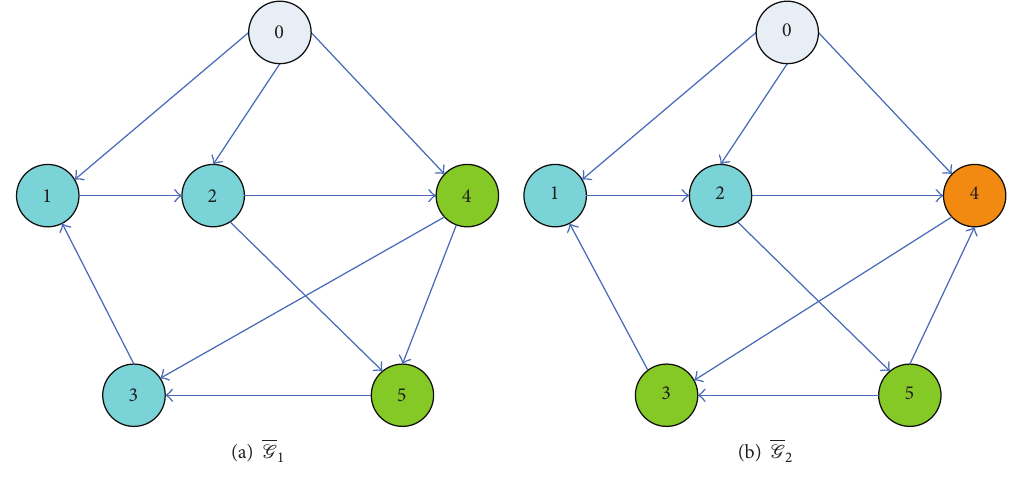
Figure 1: Interaction topologies G 1 and G 2